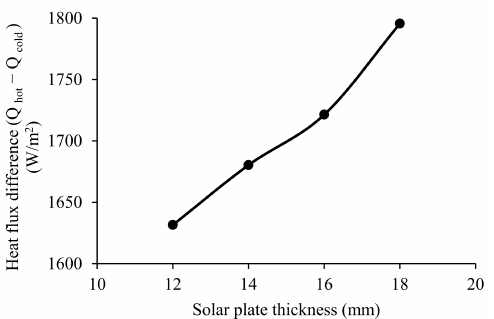
Figure 8. The relation between the solar plate thickness and the heat flux between the module’s hot and cold